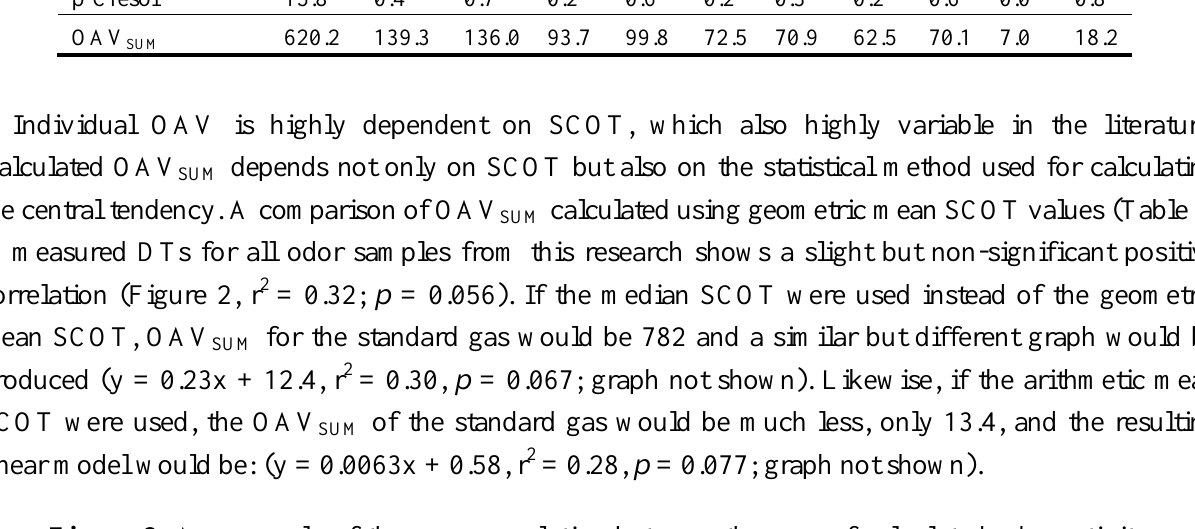
Figure 2. An example of the poor correlation between the sum of calculated odor activity values for eight compounds (OAV , from Table 5) and odor concentration (DT, from SUM Table